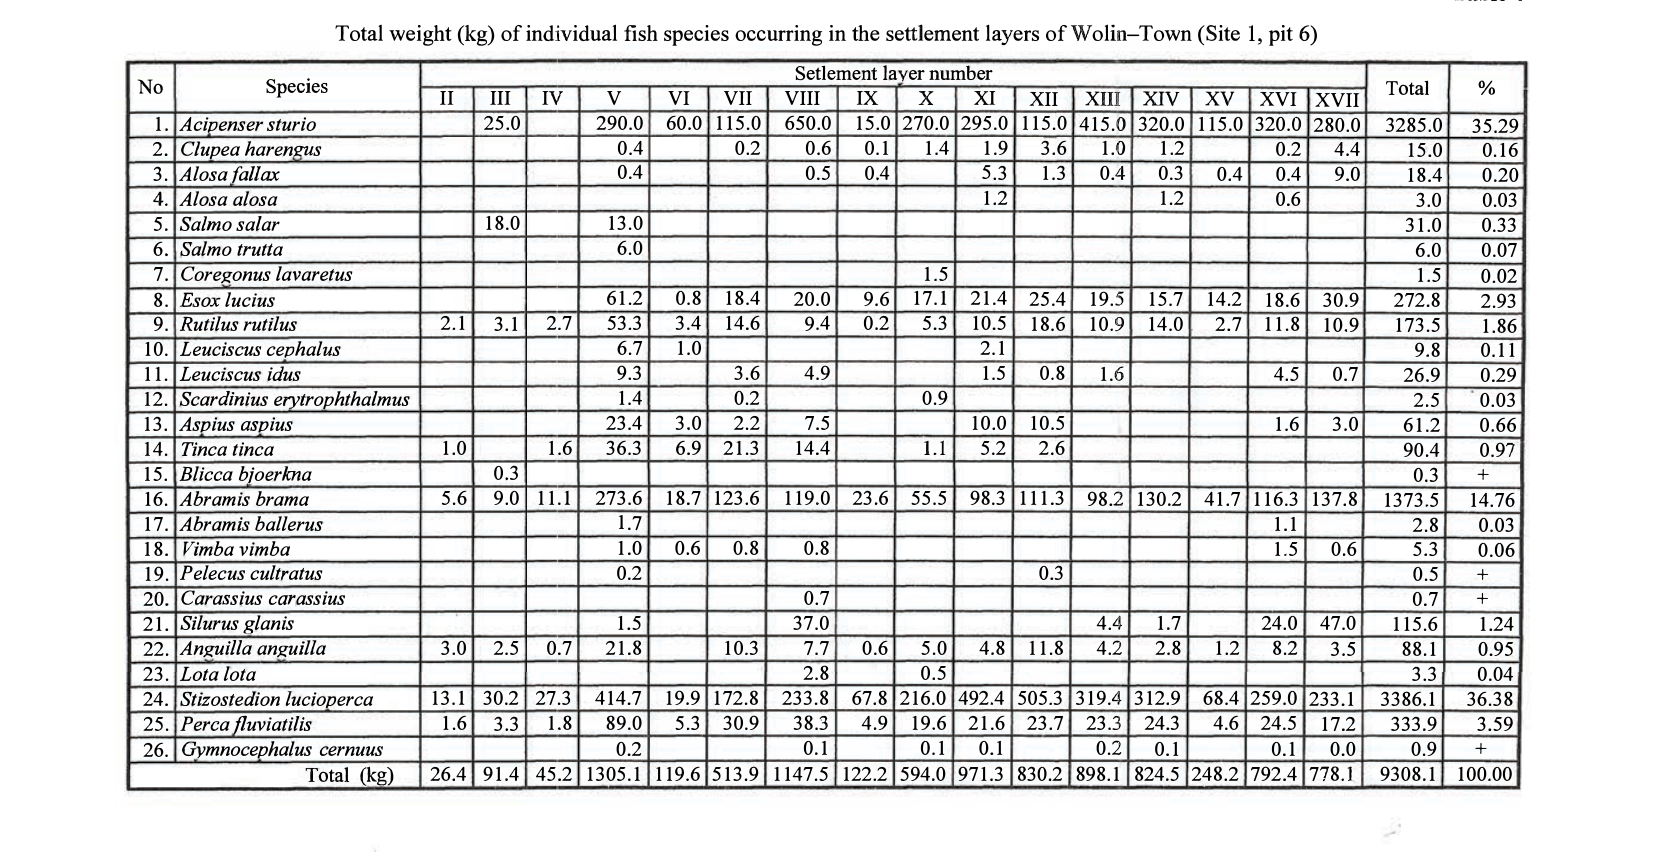
Total weight (kg) of individual fish species occurring in the settlement layers of Wolin-Town (Site 1, pit